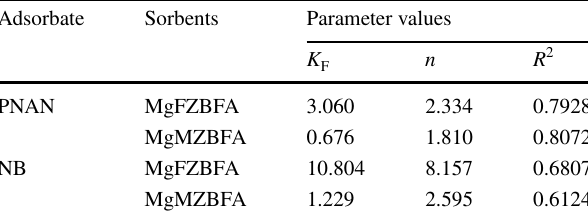
Table 5 Freundlich isotherm parameters for the sorption of PNAN and NB on MgFZBFA and MgMZBFA